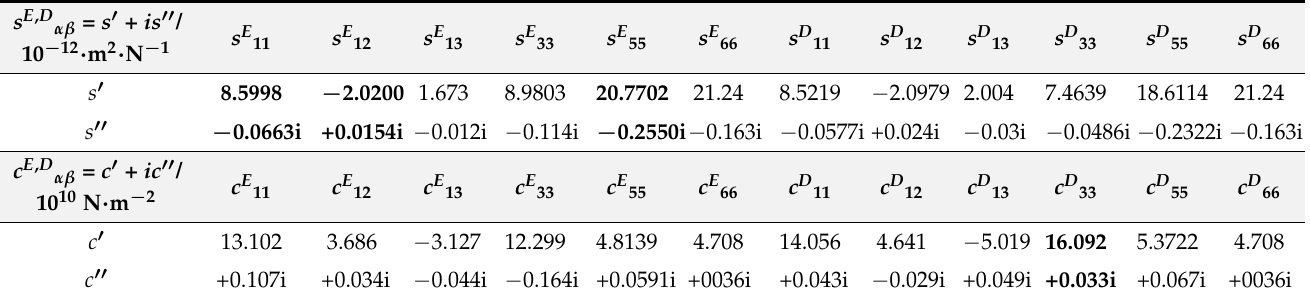
Table 1. Complex elastic coefficients of the PIC700 eco-piezoceramic ( * )